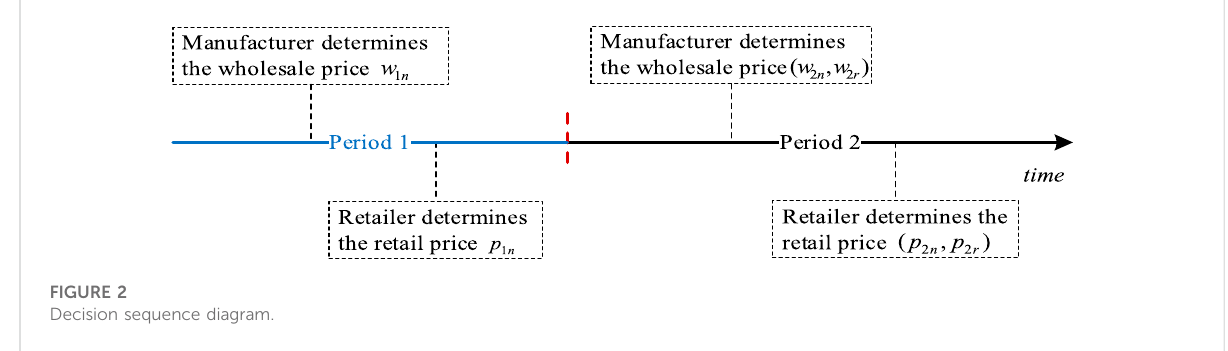
FIGURE 2 Decision sequence